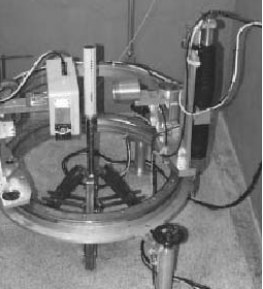
Figura 2. Vista geral do tomógrafo utilizado para determinação da densidade média do solo. Fonte: Naime